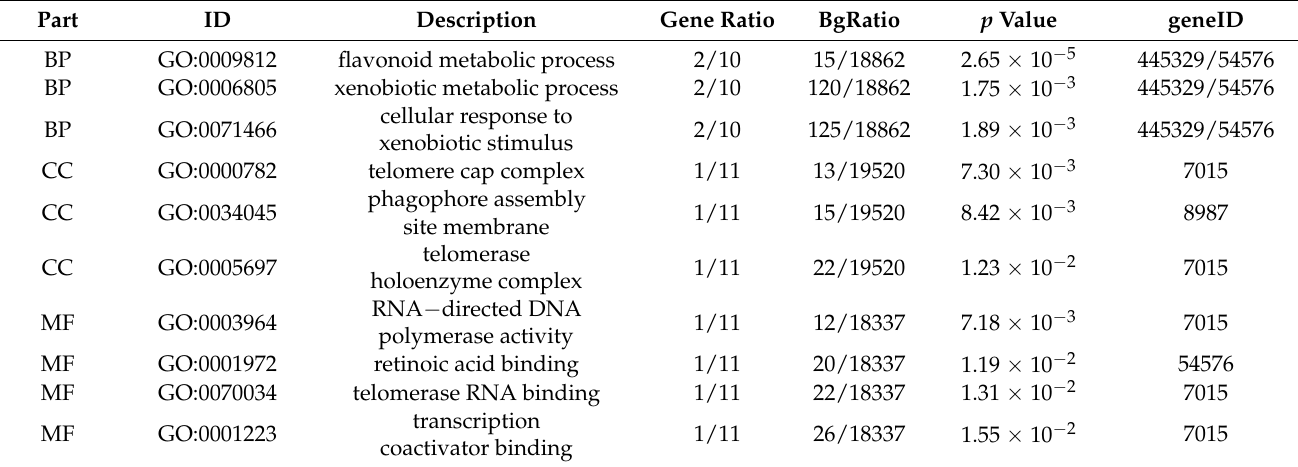
Table 2. Ten of the most highly enriched signaling pathways by GO enrichment analysis.